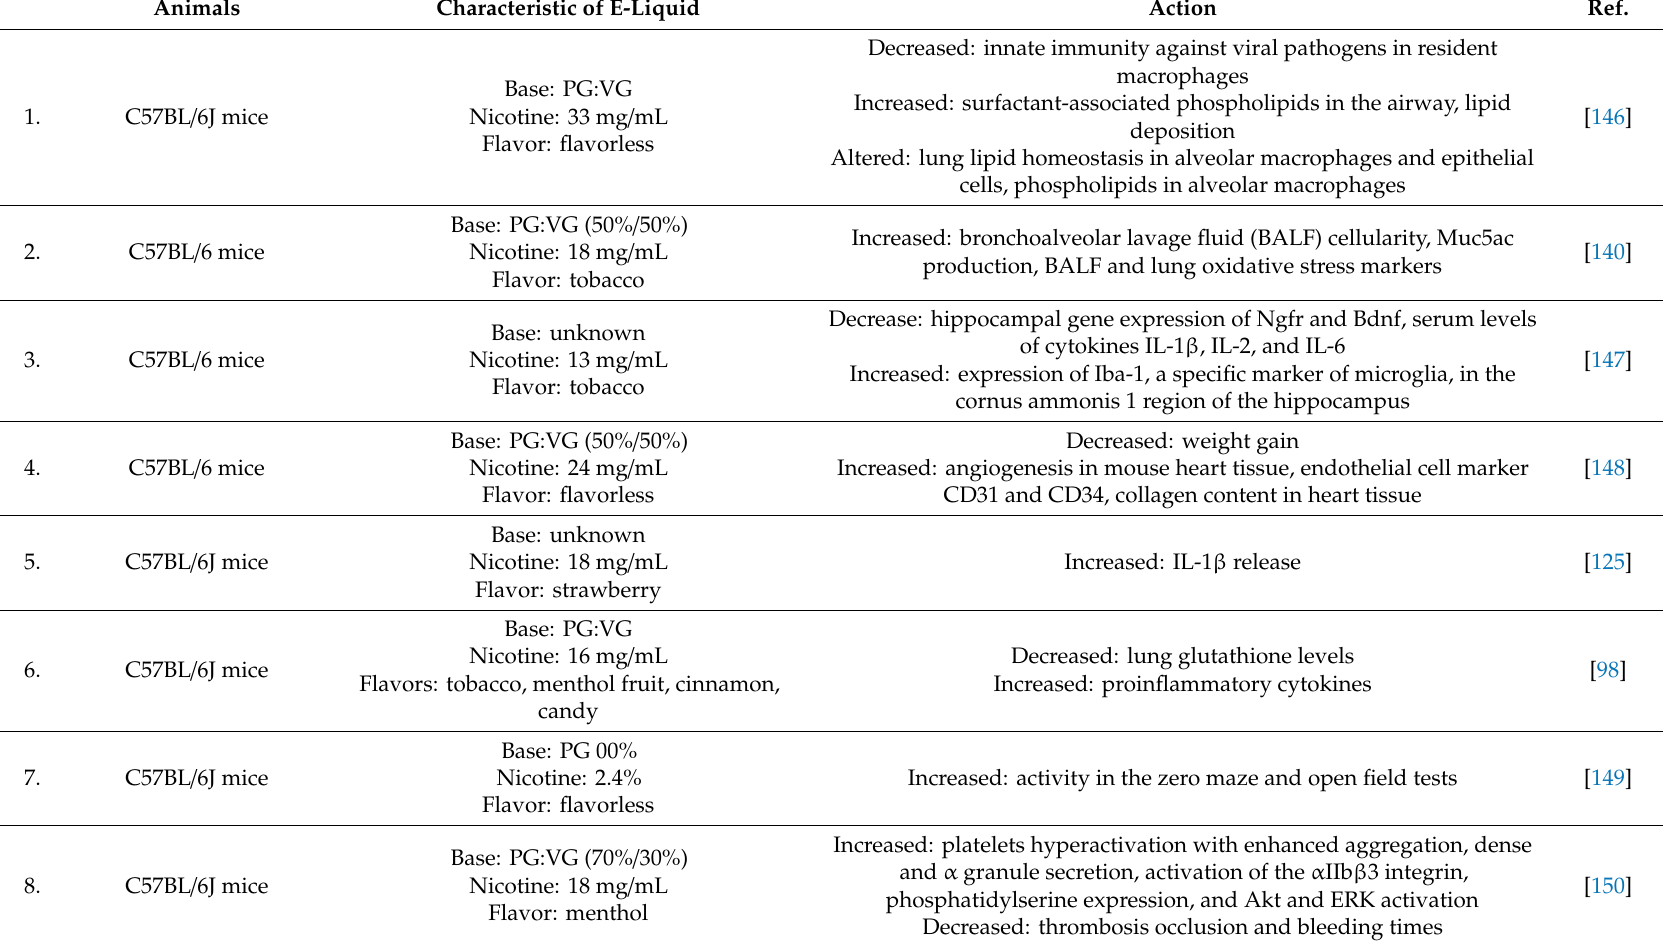
Table 2. The impact of e-cigarette liquid exposure on animal models (in vivo